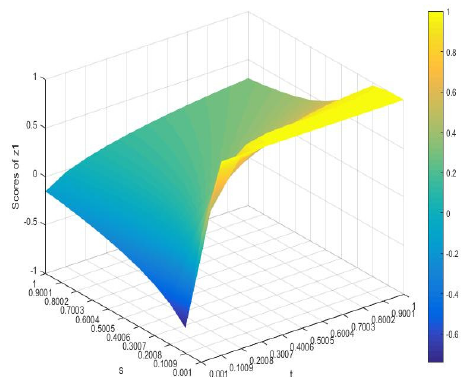
Figure 3. Score values of scheme 1.